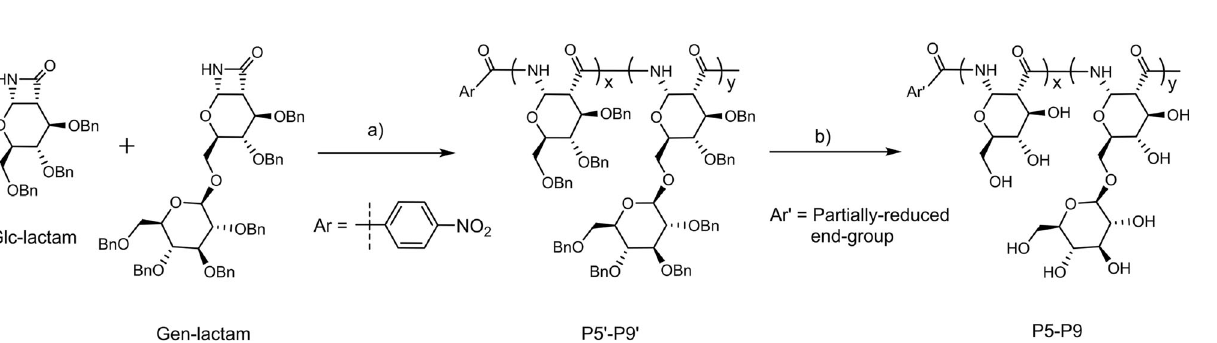
Fig. 3 | GPC and CD characterization of PAS polymers. a THF GPC traces of polymers P1 ’ -P4 ’ ; b Water GPC traces of polymers P1-P4; c CD spectra of polymers P1-P4 in water at 25°C; d CD spectra of polymer P3 in water under various